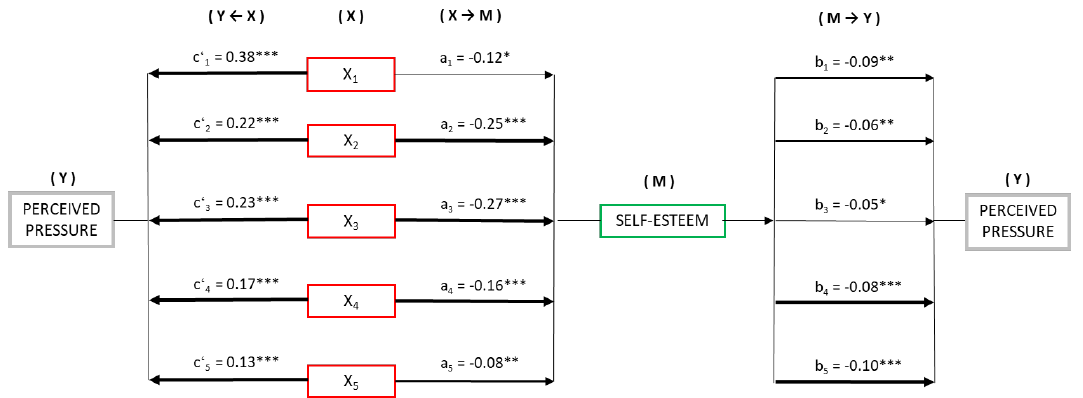
Figure 3. Mediation model of self-esteem on the relationship between risk variables and perceived group pressure to drink alcohol (Note: X 1 = PE, X 2 = ANXc, X 3 = ANXs, X 4 = ANXp, X 5 = GI. * p < 0.05, ** p < 0.01, *** p < 0.001).